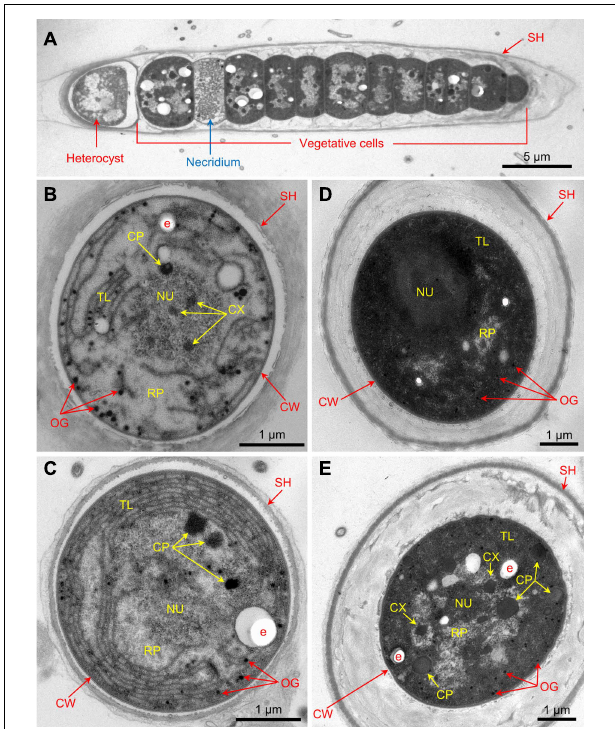
FIGURE 5 | Thin sections of (A) a filament, (B,C) heterocysts, and (D,E) vegetative cells of the FL- C strain. SH, sheath; CW, cell wall; TL, thylakoids; RP, riboplasm; NU, nucleoid; CP, cyanophycin granule; CX, carboxysome; OG, osmiophilic granule; e, electron-transparent area.